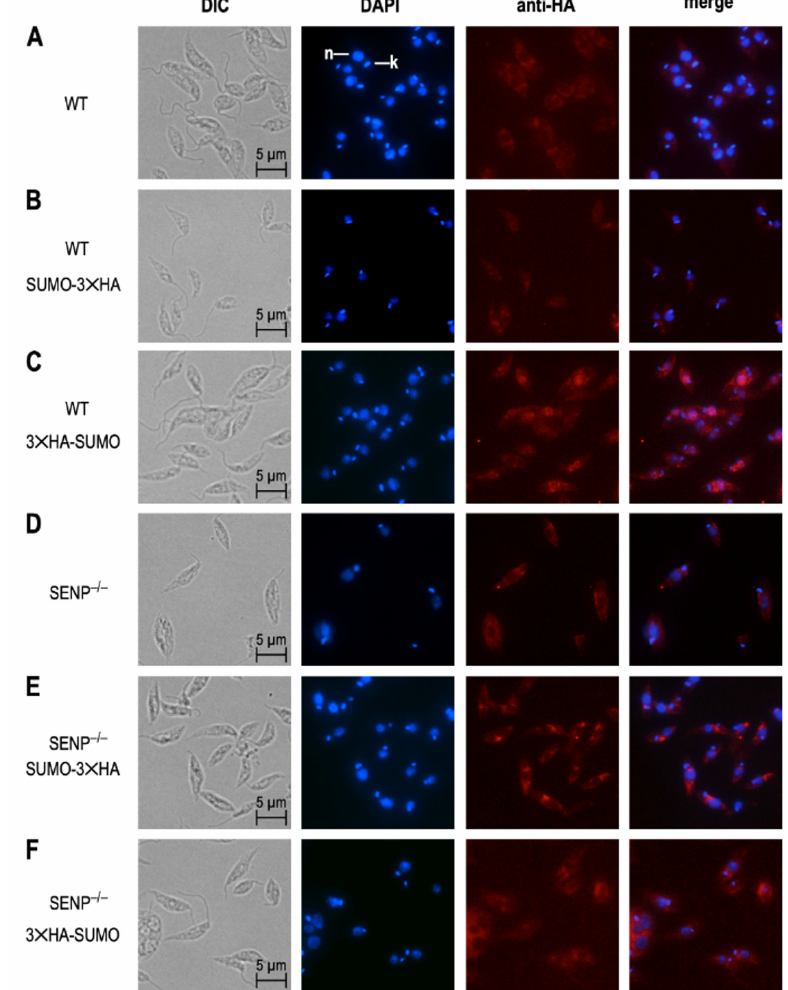
Figure 5. Subcellular localisation of HA-tagged SUMO. Wild type (WT) ( A ) or L. donovani SENP − / − ( D ) cells expressing SUMO-3 × HA ( B , D ) or 3 × HA-SUMO ( C , F ). Cells were visualized by di ff erential interference contrast (DIC), DAPI staining of nucleus and kinetoplast, and mouse anti-HA antibody / anti-mouse AlexaFluor 594. DAPI and anti-HA images were merged with 50% transparence. Size markers (5 µ m) are shown in the DIC images; nucleus (n) and kinetoplast (k) are pointed out in the top DAPI